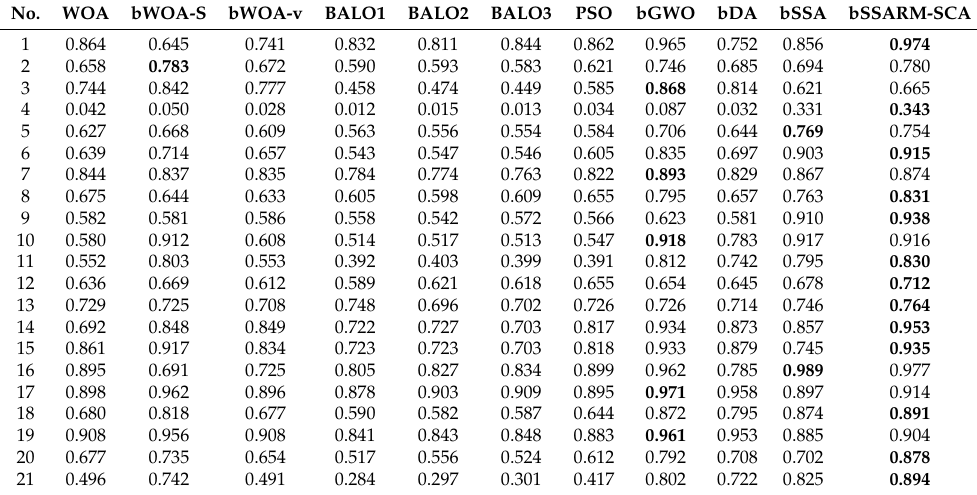
Table 11. Classification accuracy using small initialization for the 21 utilized datasets.